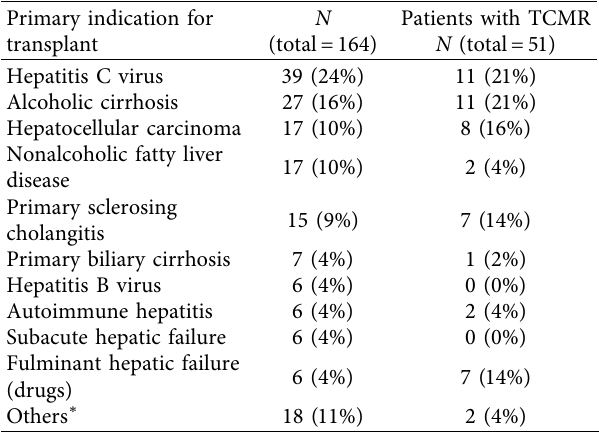
Table 2: Primary indications for transplant for adult patients who underwent liver transplantation in the study in 2015 and 2016 and the primary indications for transplant for adult patients from the cohort who were diagnosed with biopsy-proven T-cell mediated rejection (TCMR) within one year of transplantation.